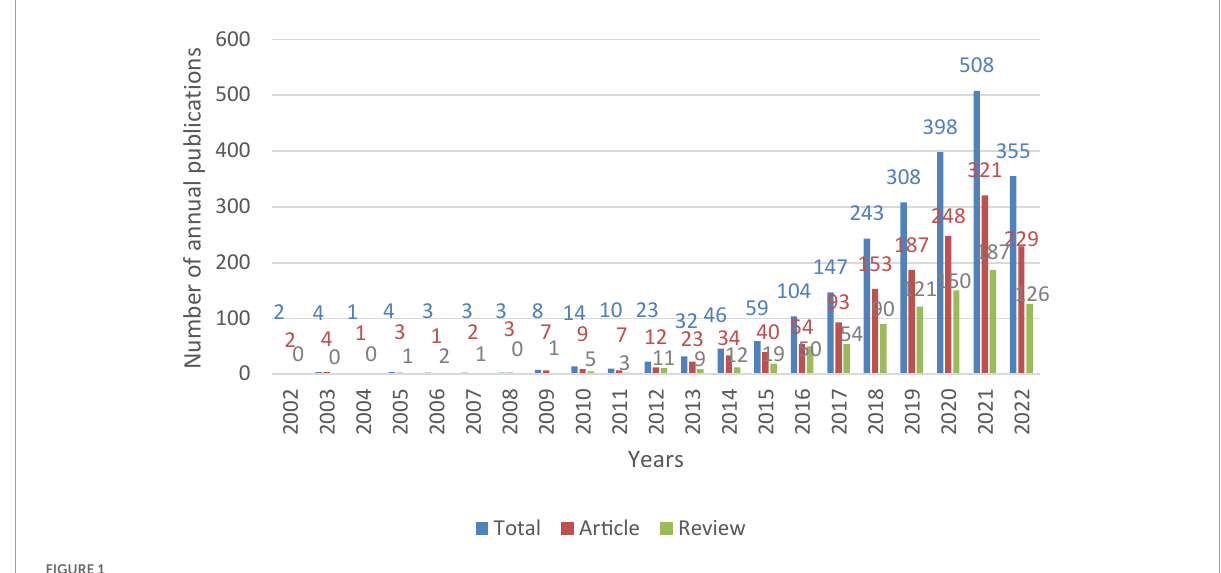
FIGURE1 Trends in the number of publications for research in the gastrointestinal microbiome and neuroscience from 2002 to 2022.